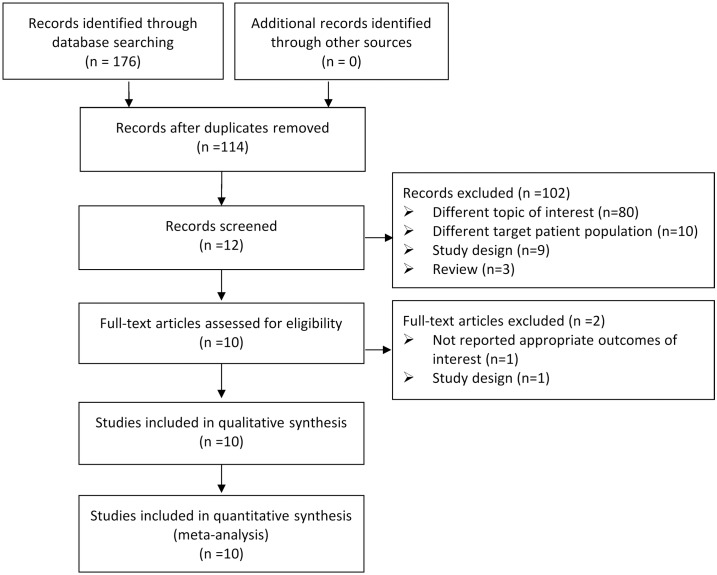
Flow chart summarizing the selection of relevant articles.